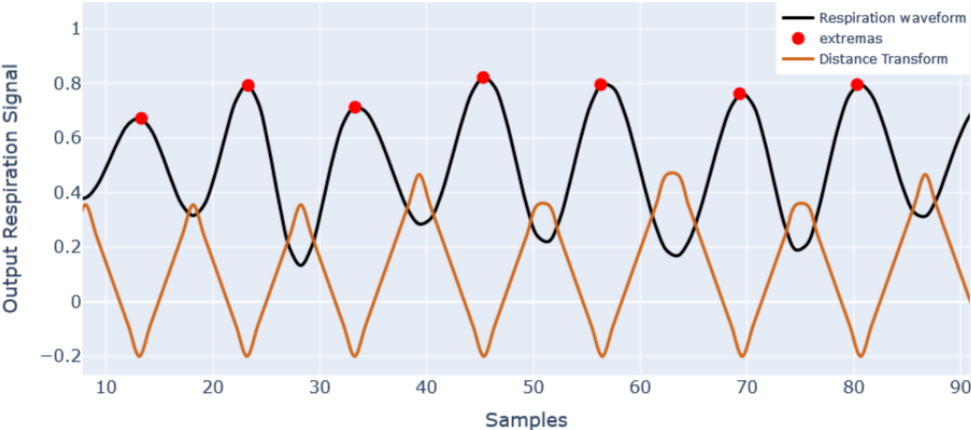
Figure 4. Random snippet of a final estimated breathing cycle andits distance